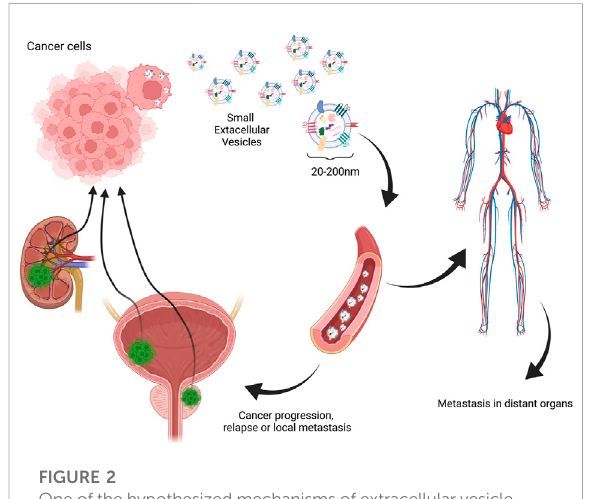
FIGURE 2 One of the hypothesized mechanisms of extracellular vesicle involvementinrelapse, local,anddistant metastasis inurinarytract carcinomas. Created with biorender.com.